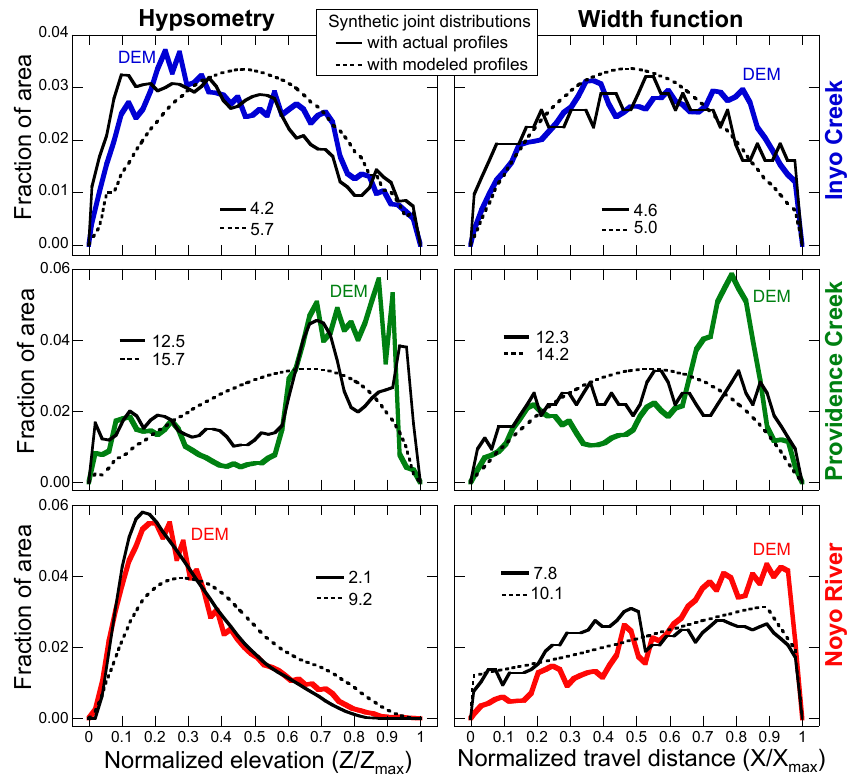
Figure 12. Comparison of actual with modeled hypsometric curves and width functions for three study catchments. In each panel, thick colored curves show data from catchment DEM, while thick and dashed black lines show model predictions using actual and modeled channel and ridge profiles, respectively. Values in parentheses indicate RMSE calculated by comparing model curves with